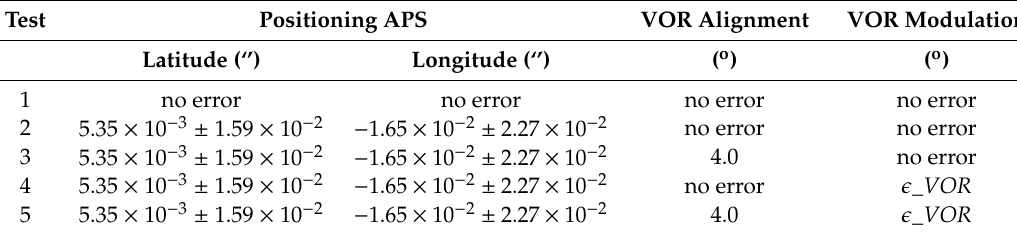
Figure 9. Mission dataflow. The Processing block is part of the complete HIL platform depicted in Figure 5. Table 9. Errors inserted in the system for each test.